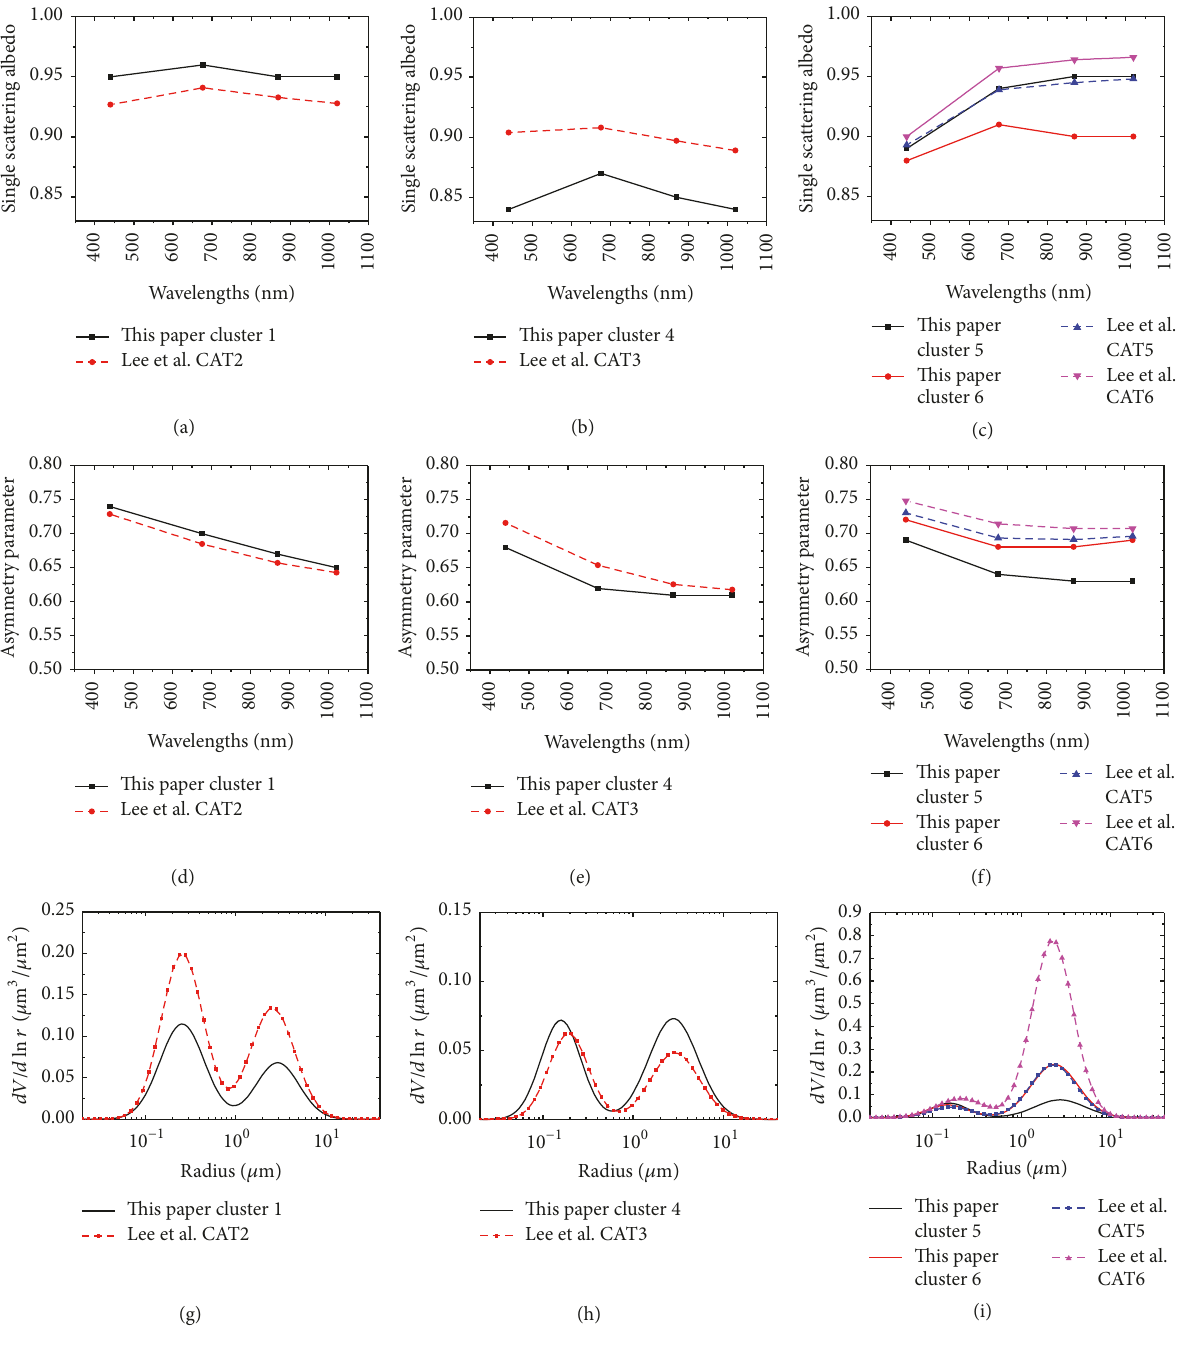
Figure 8: Comparison with East Asian aerosol types. Table 5: The record numbers within each membership degree